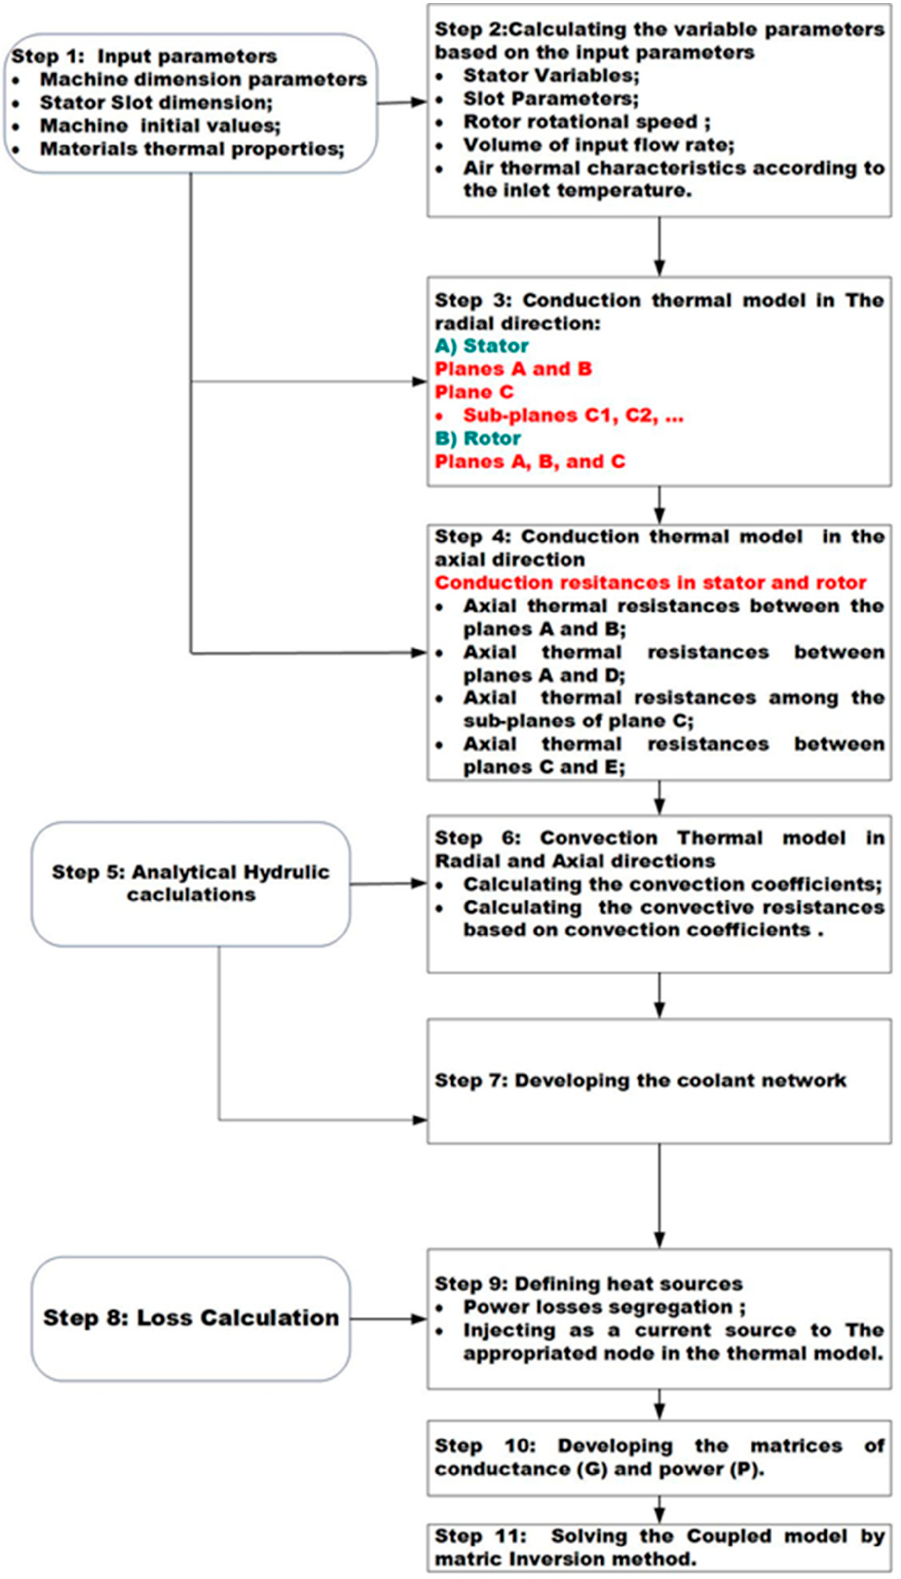
Figure 7. The flow chart and code algorithm of the multi-plane thermal model.